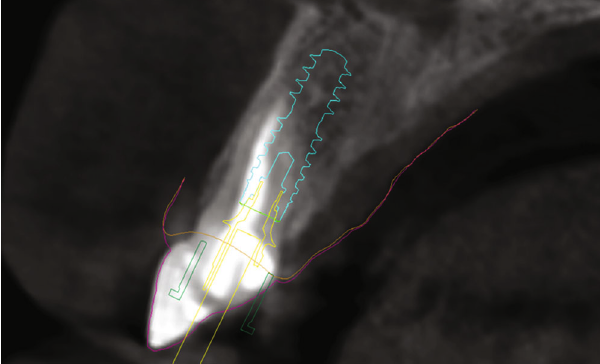
Figure 5: The old crown removal and root preparation/sectioning.